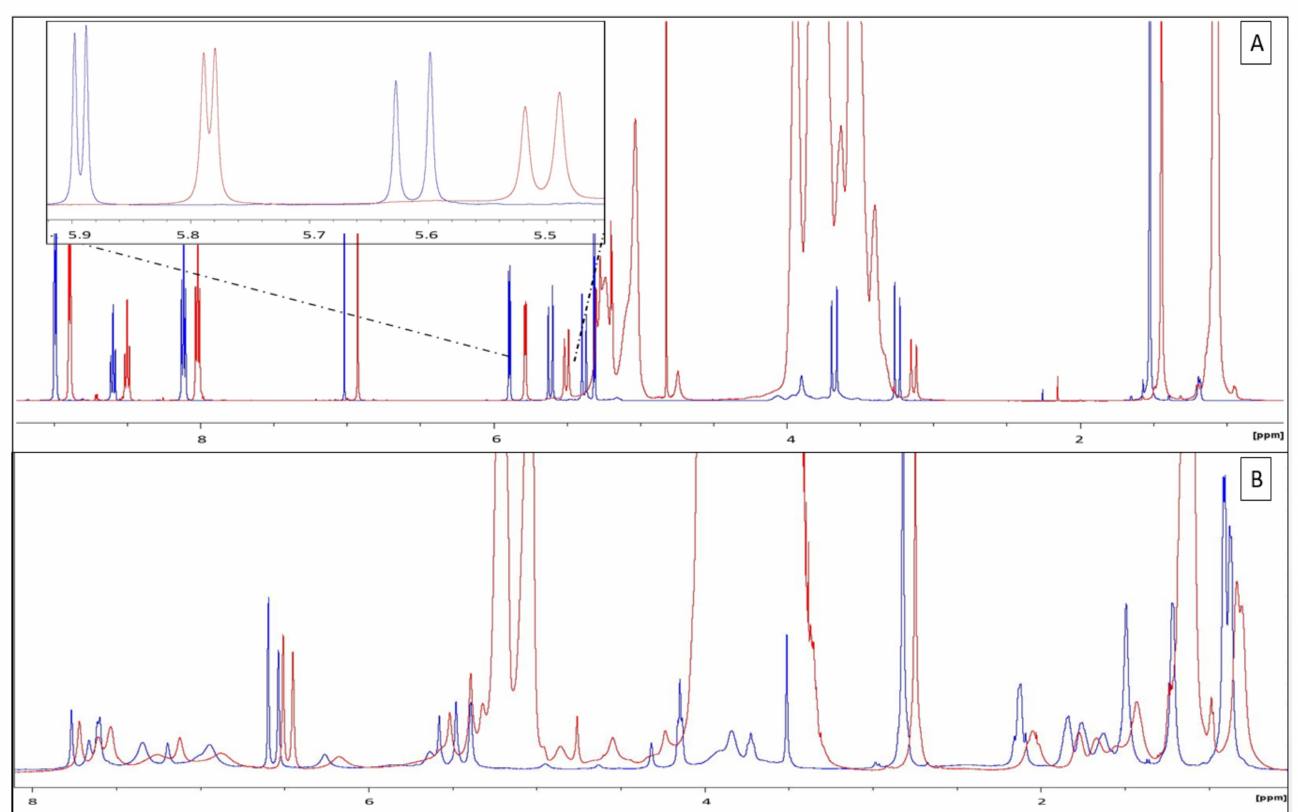
Figure 2. Nuclear magnetic resonance spectra of ( A ) ceftazidime (blue curve) and ceftazidime/hydroxypropyl- γ - cyclodextrins (red curve) at 50 mg/mL at pH 4, ( B ) vancomycin (blue curve) and vancomycin/hydroxypropyl- β - cyclodextrins (red curve) at 50 mg/mL at pH